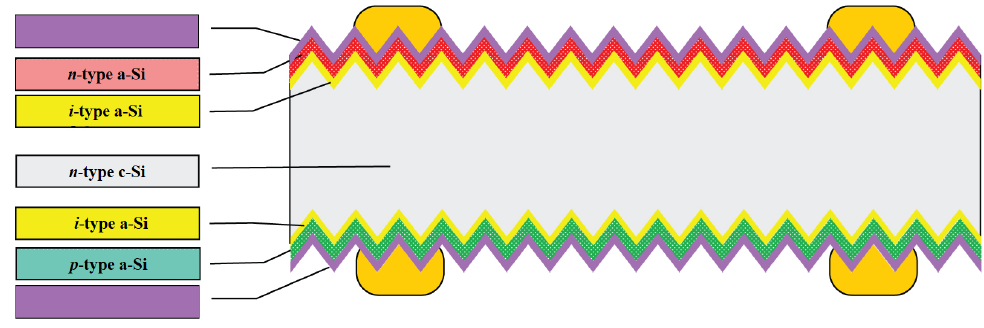
Figure 8. Silicon solar cell structures: heterojunction (SHJ) in rear junction configuration [1].